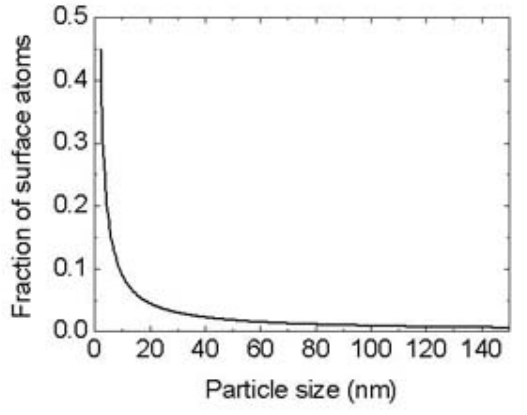
FIGURE 2. Fraction of surface atoms as a function of the particle size for cubic shape ( α = 6) and in teratomic distance a = 1.5